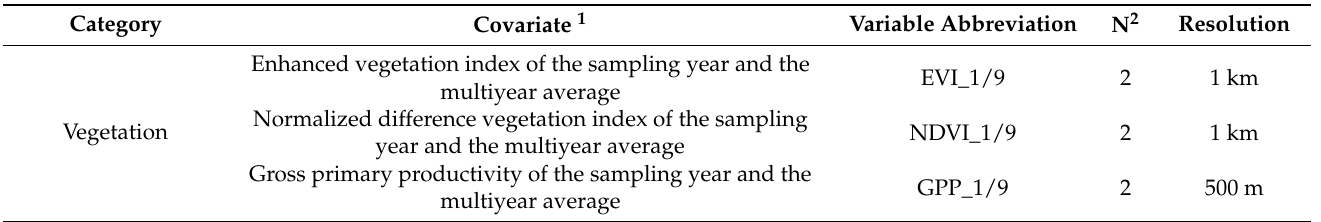
Table 1. Environmental covariates for predicting soil particle size